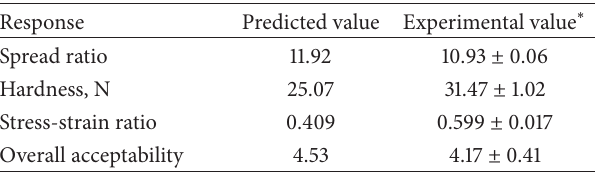
Table 4: Verification of the models by comparing the experimental values with the predicted